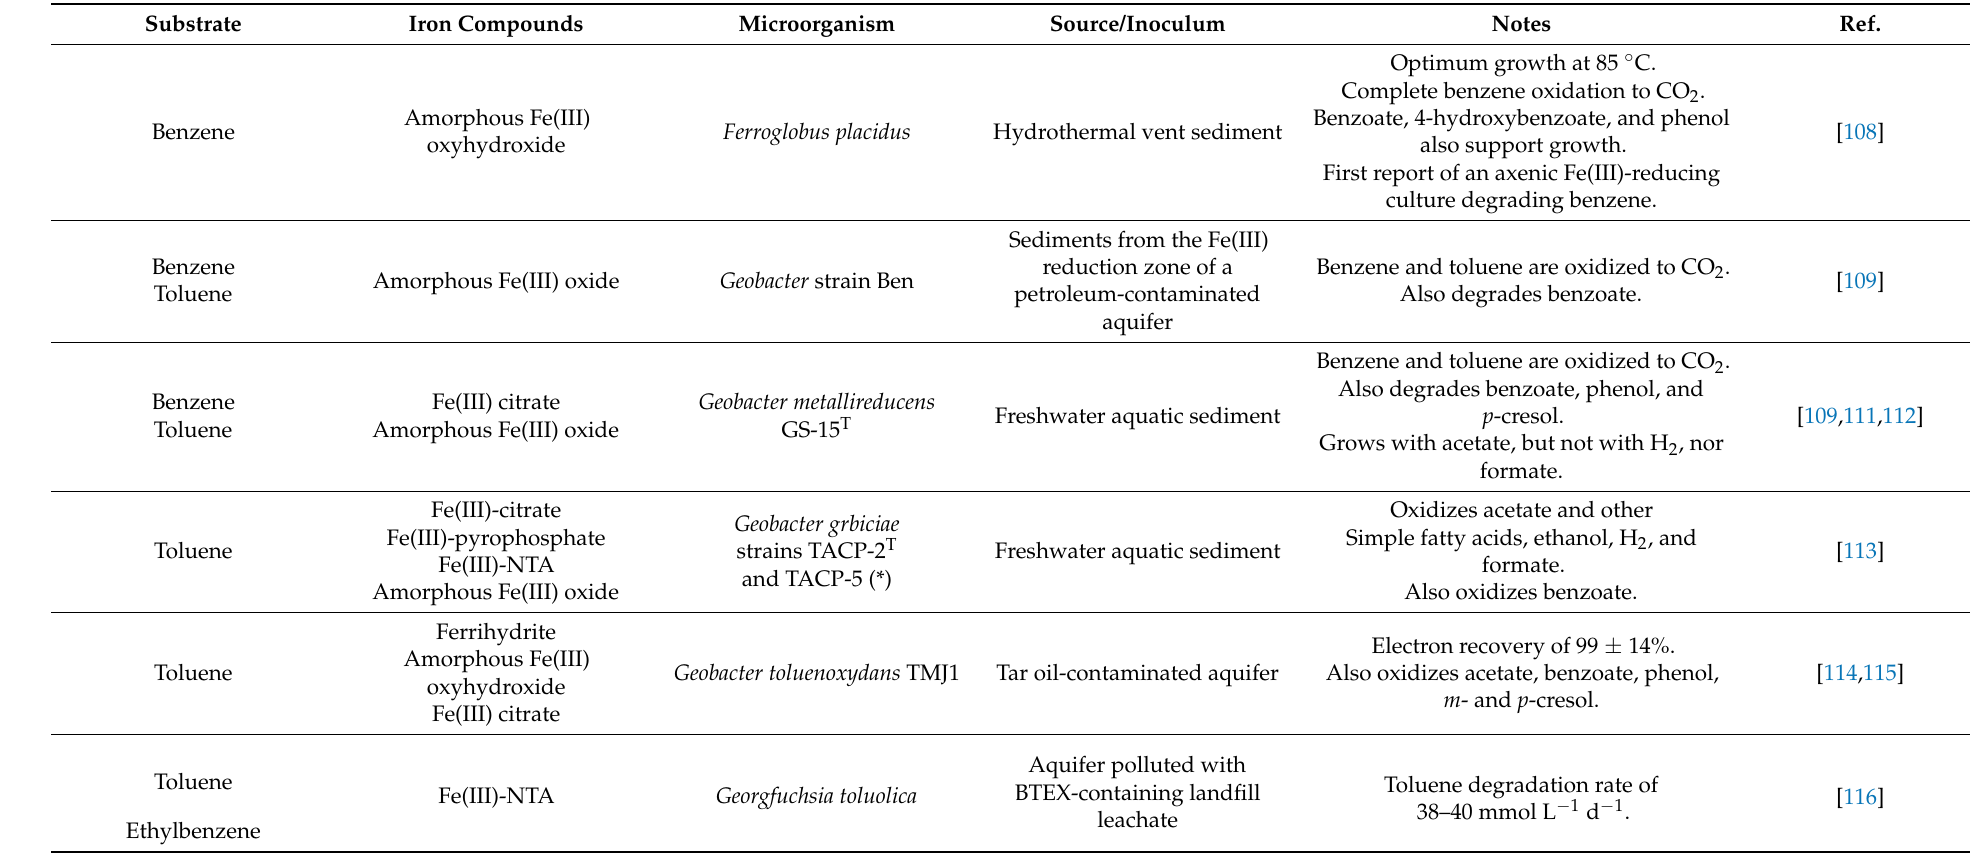
Table 2. Overview of axenic microbial cultures able to degrade aromatic hydrocarbons coupled to Fe(III)